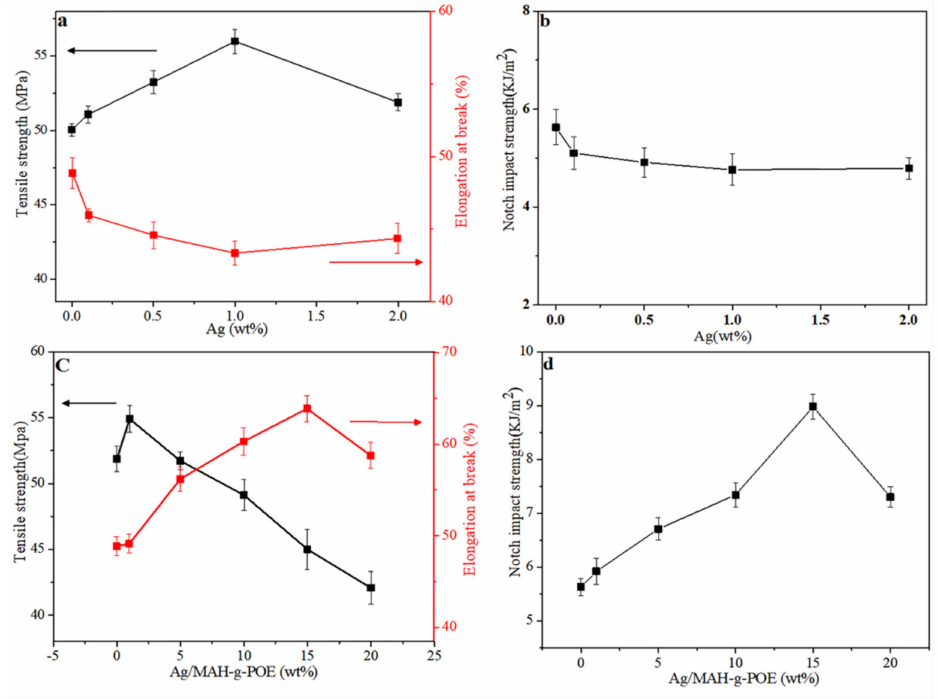
Figure 6. ( a ) Tensile strength and elongation at break and ( b ) impact strength of POM/Ag nanocom- posites; ( c ) tensile strength and elongation at break and ( d ) impact strength of POM/Ag/MAH- g -POE ternary